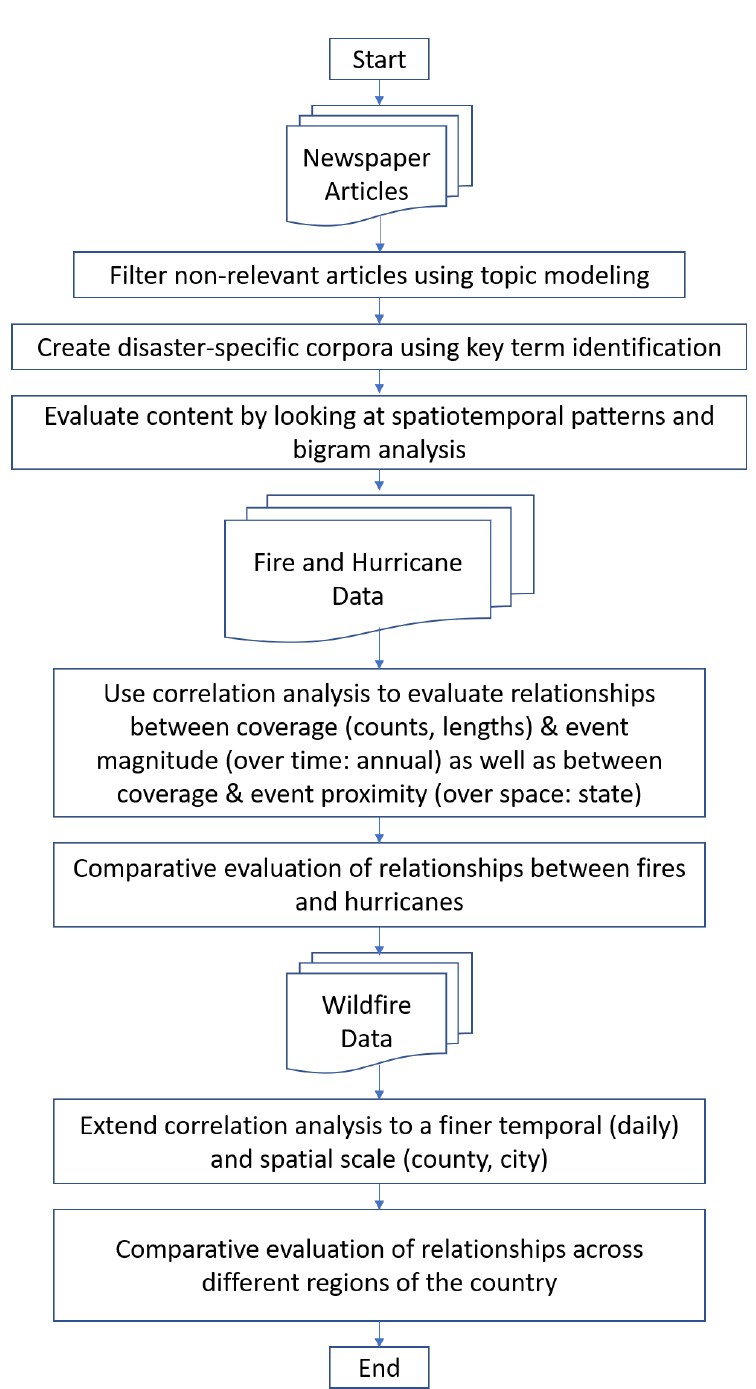
Figure 1. Overview of the data types and analytical methods used in this study. Correlations for fire and hurricane data were conducted at the annual time scale and state-level spatial scale due to data limitations. The wildfire case study enables extensions of these insights to look at finer resolutions at the daily time scale and county-/city-level spatial